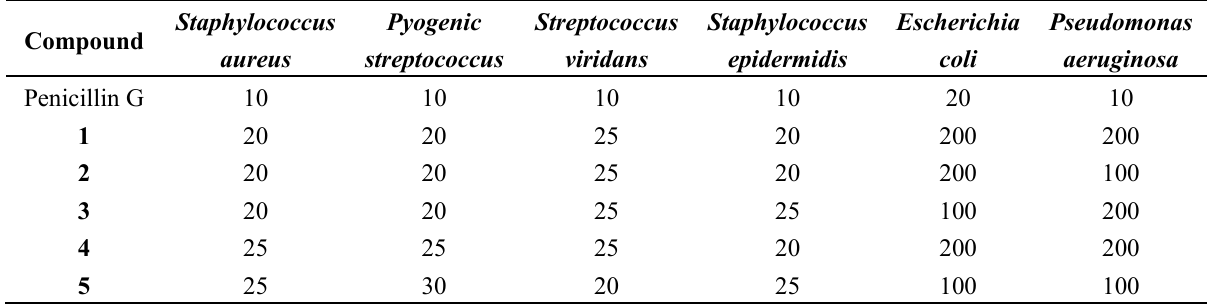
Table 2. The antibacterial activities of the compounds (MIC, μ